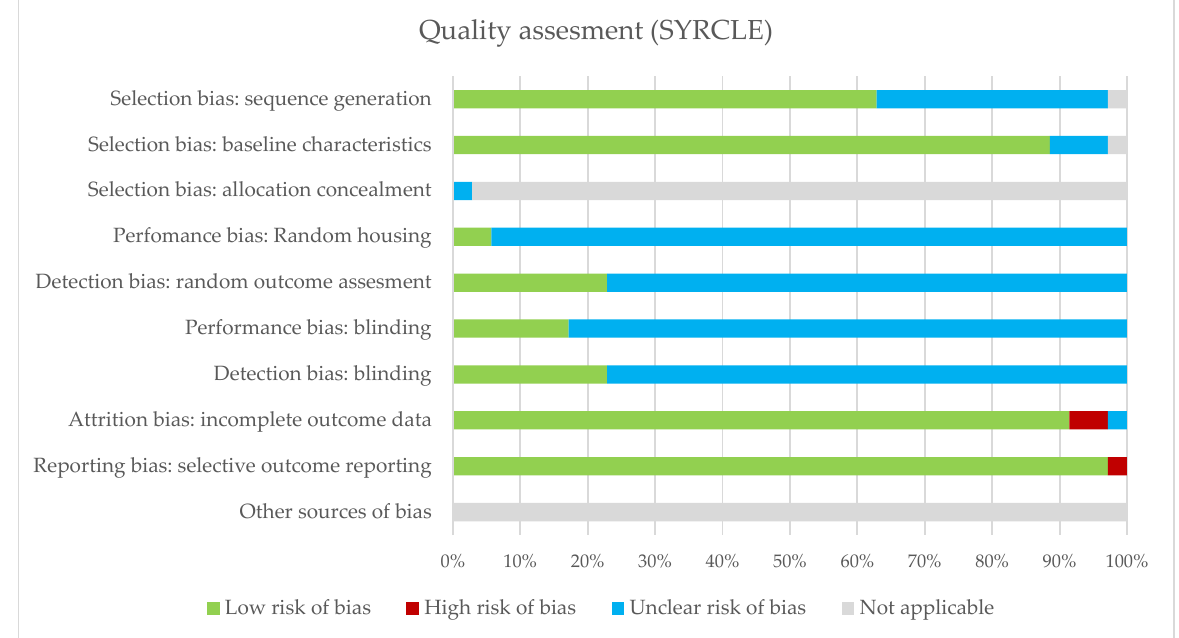
Figure 3. Quality assessment of animal studies using the SYRCLE tool.